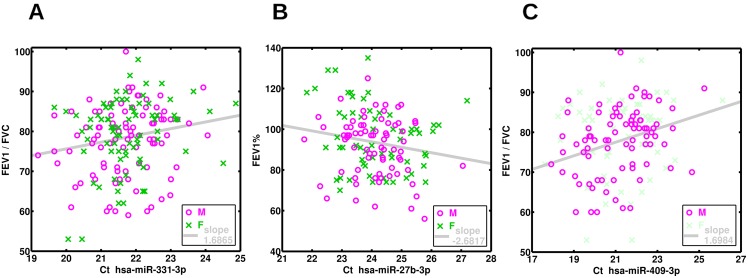
Three examples of microRNAs associated with lung function measures.(A) Association of serum miR-331-3p with FEV1/FVC in childhood asthma. (B) Association of serum miR-27b-3p with FEV1% in childhood asthma. (C) Sex-specific association of miR-409-3p with FEV1/FVC in asthmatic boys.